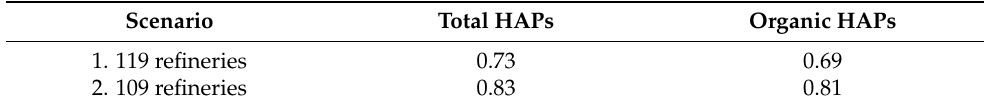
Table 2. Recap of r values for both scenarios 1 and 2 and both total HAPs emission and only organic HAPs emission.